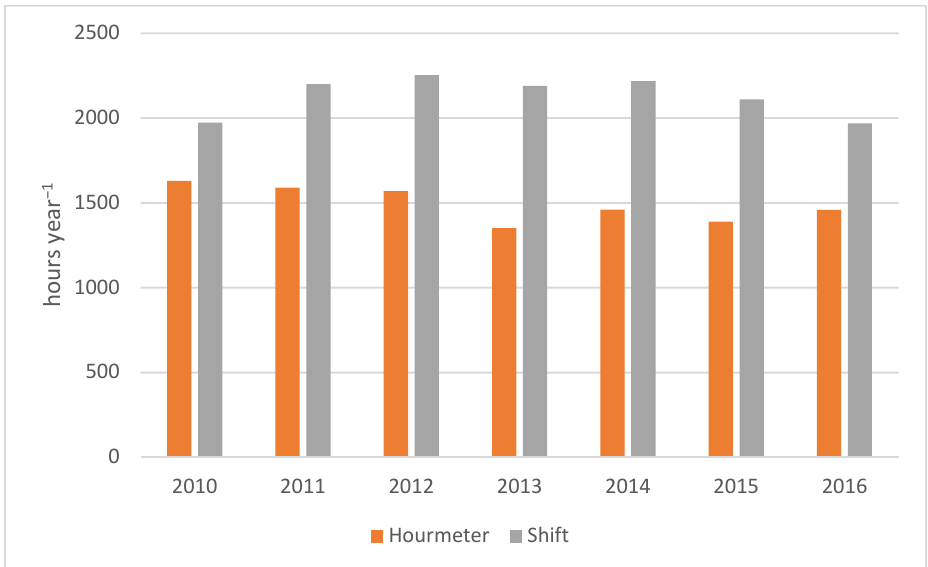
Figure 2. Annual use in shift hours and meter hours.